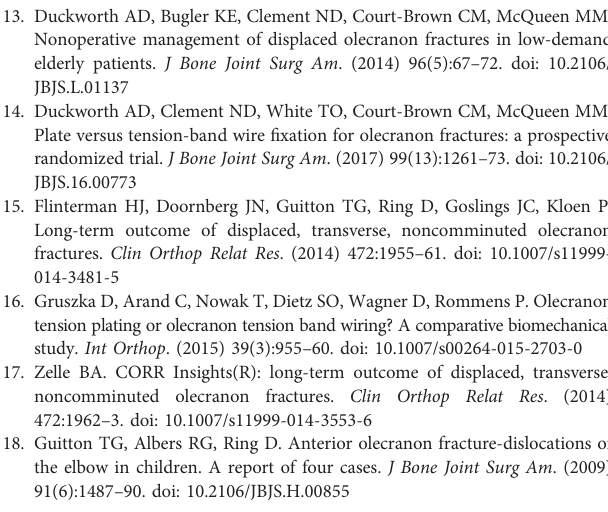
Supplementary Figure 1 | Typical case of Mayo type IIa olecranon fracture treated with J-EF fi xation. Male patient, 30 years, traf fi c accident. Preoperative ( A ) and postoperative X-rays of the elbow joint were shown in A-D . The elbow joint function 3 months postsurgery ( E-G ) as well as 16 years follow-up ( H-J ) of the patient were shown in the supplementary